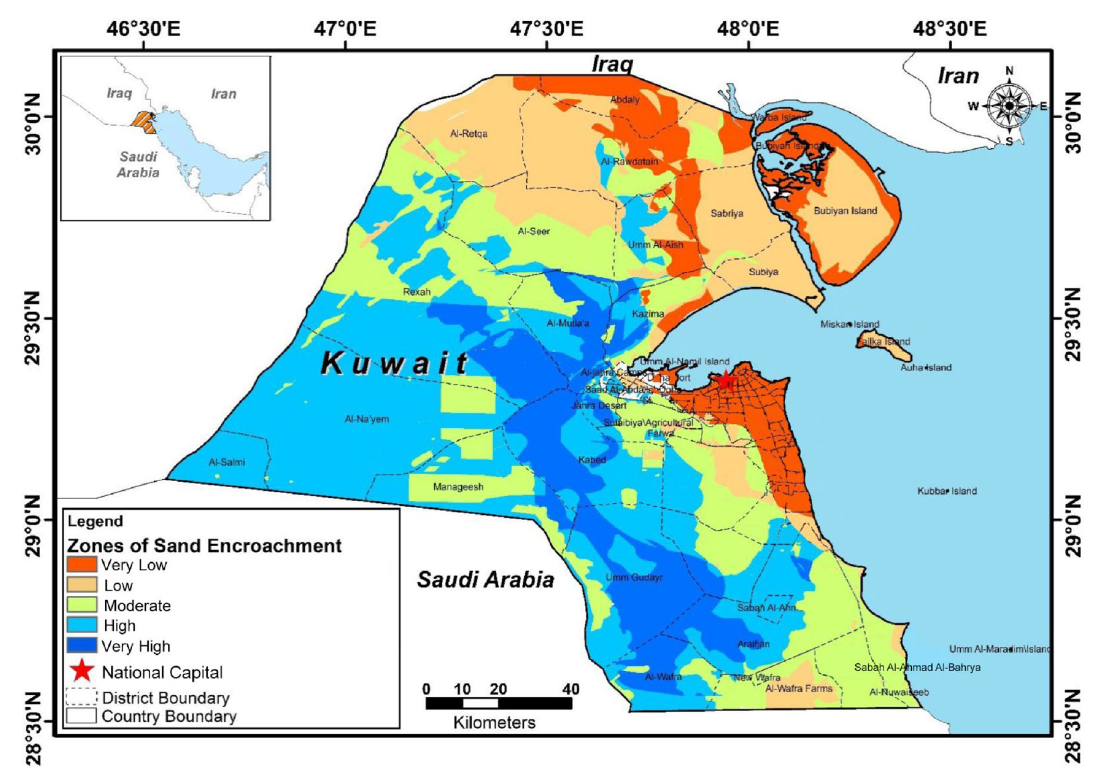
Fig. 6 Sand encroachment hazard map for Kuwait. Source Kuwait Institute for Scientific Research (KISR)